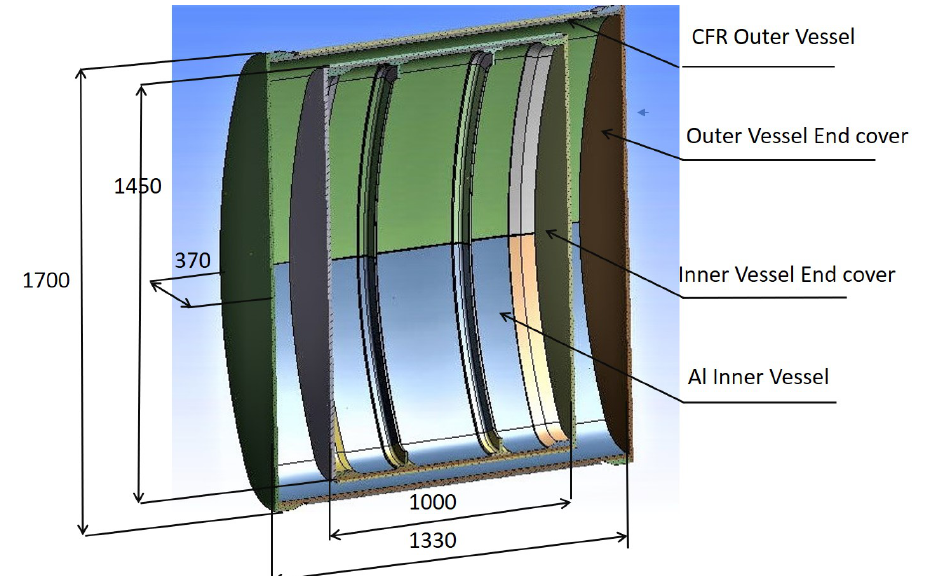
Figure 131. Conceptual design of the active LAr target cryostat to be located in the upstream part of the volume inside the ECAL. The dimensions shown are in units of